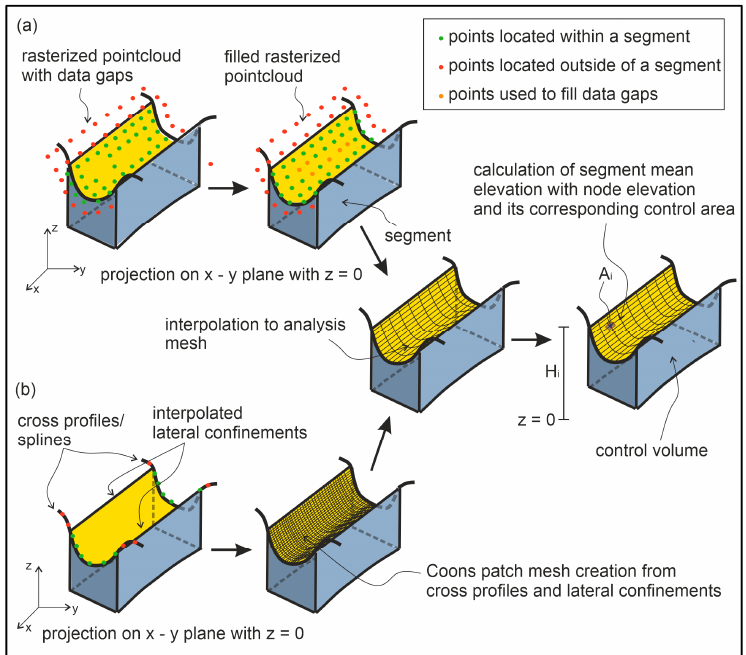
Figure 3. Procedure of mean elevation calculation for SPA data ( a ) and DCP data ( b ).